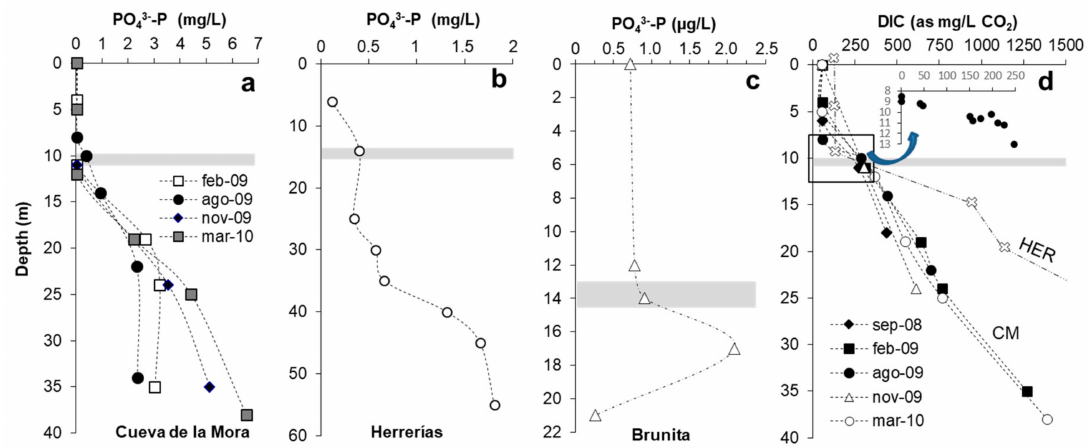
Figure 8. Vertical profiles of phosphate phosphorus concentration obtained in Cueva de la Mora (di ff erent seasons, a ), Herrer í as (July 2011, b ) and Brunita (Nov 2018, c ). ( d ) Vertical profile of dissolved inorganic carbon (DIC, as mg / L CO 2 ) in Cueva de la Mora (CM) and Herrer í as (HER) APL as measured in di ff erent seasons. The inset shows magnification of the chemocline zone with a high resolution profile conducted in September 2011 between 8 and 13 m depth in CM. The DIC concentration at depth in HER is much higher (5000 mg / L) and is not represented for clarity. The shaded area indicates the approximate position of the chemocline in all cases.